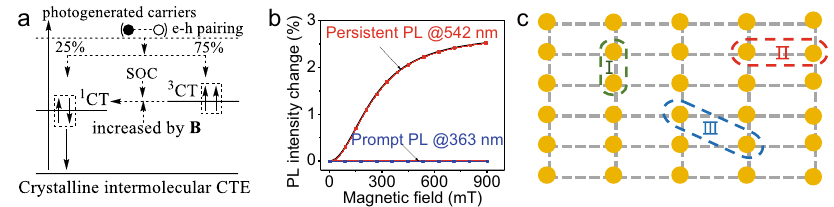
Fig. 4 Characteristics of crystalline intermolecular charge-transfer excitons (CTE) in organic molecular crystal. a Diagram to show electron – hole pairing to form singlet and triplet crystalline intermolecular charge-transfer excitons (CTE) with 25% and 75%. SOC fl ips spins, enabling exothermic triplet-to- singlet intersystem crossing in crystalline intermolecular charge-transfer excitons. Magnetic fi eld increases triplet-to-singlet intersystem crossing by introducing faster and slower spin precessions due to different g factors on electrons and holes. b Magnetic fi eld effects measured for long-wavelength persistent PL (at 542 nm with ultralong lifetime of 0.43 s) and short-wavelength prompt PL (at 363 nm with short lifetime of 0.45 ns; λ ex = 325 nm). c . The diagram shows crystalline intermolecular charge-transfer excitons through three different electron – hole captures labeled with I , II , and III types within crystalline lattice from periodically packed intramolecular D – A structures. Each dot represents an intramolecular D – A